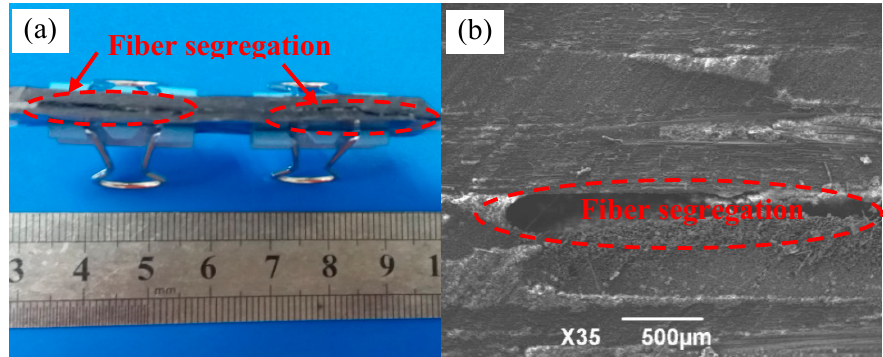
Figure 5. The defect of weak interlaminar binding force of 2D-T700/E44 composite prepared by ICM. ( a ) Macrograph defect; ( b ) Micrograph defect.